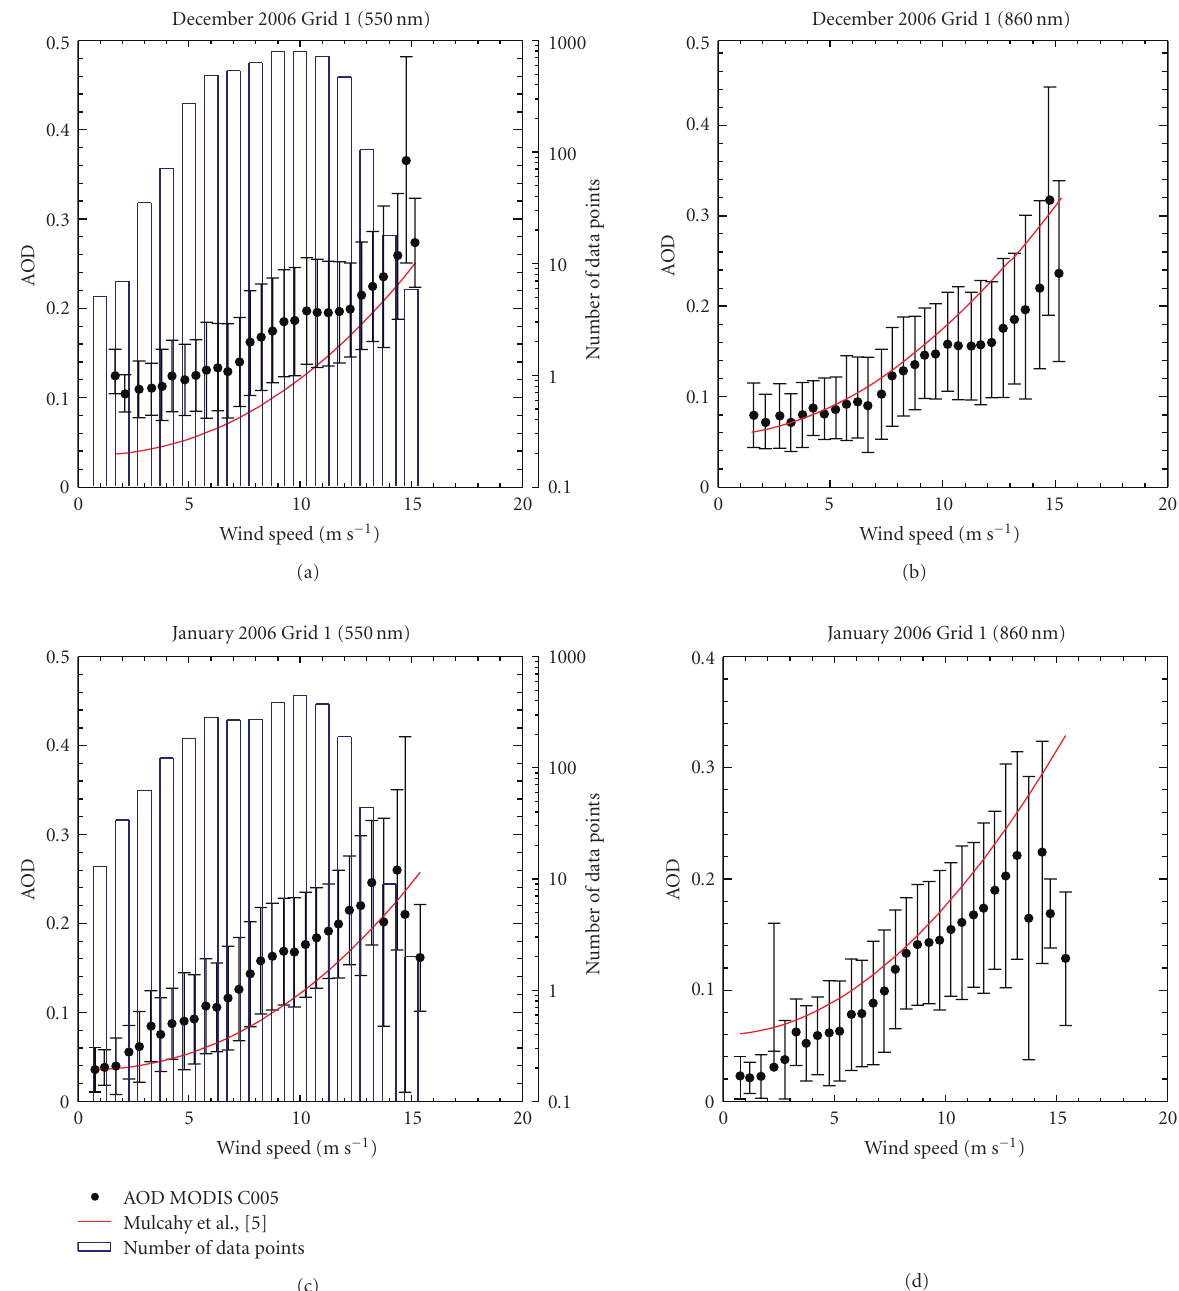
Figure 2: This Figure compares MODIS C005 AOD data at 550nm and 860 nm (together with the standard deviation of AOD data within each bin) for Grid 1 during December and January 2006 with the Mulcahy et al. [5] AOD-wind speed relationship. Also shown is the number of data points per wind speed average